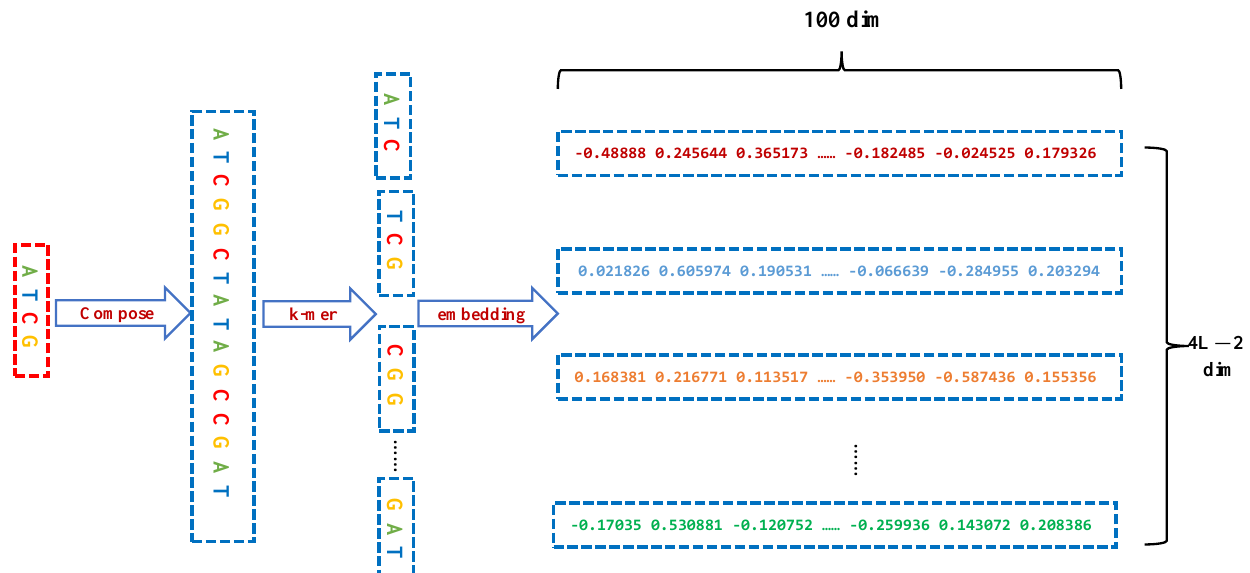
Figure 1. Each input DNA sequence of 200 bp concatenated by its three types of variant sequences so that a 800 bp sequence is constructed, which is followed by k -mers encoding and distributed representation by the word2vec